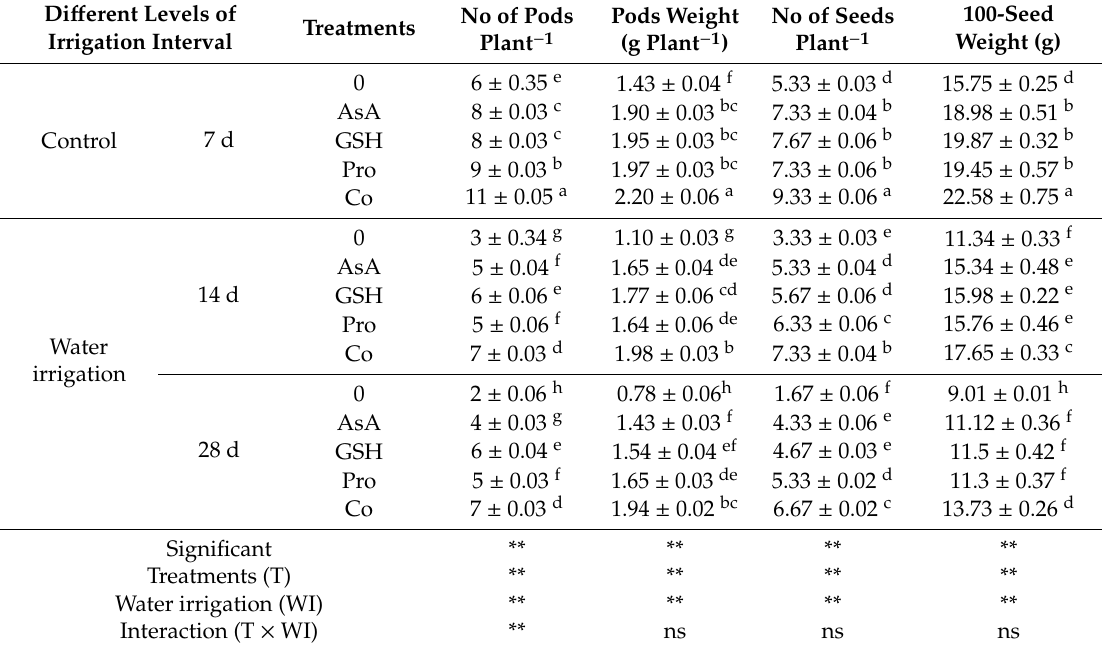
Table 2. E ff ect of ascorbic acid, glutathione and proline on yield attributes of chickpea plants under di ff erent levels of irrigation